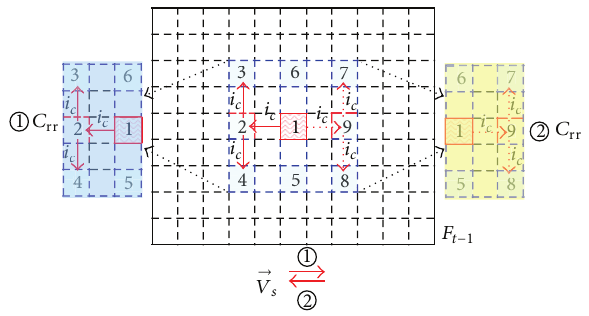
Figure 7: Schematic diagram of 𝐶